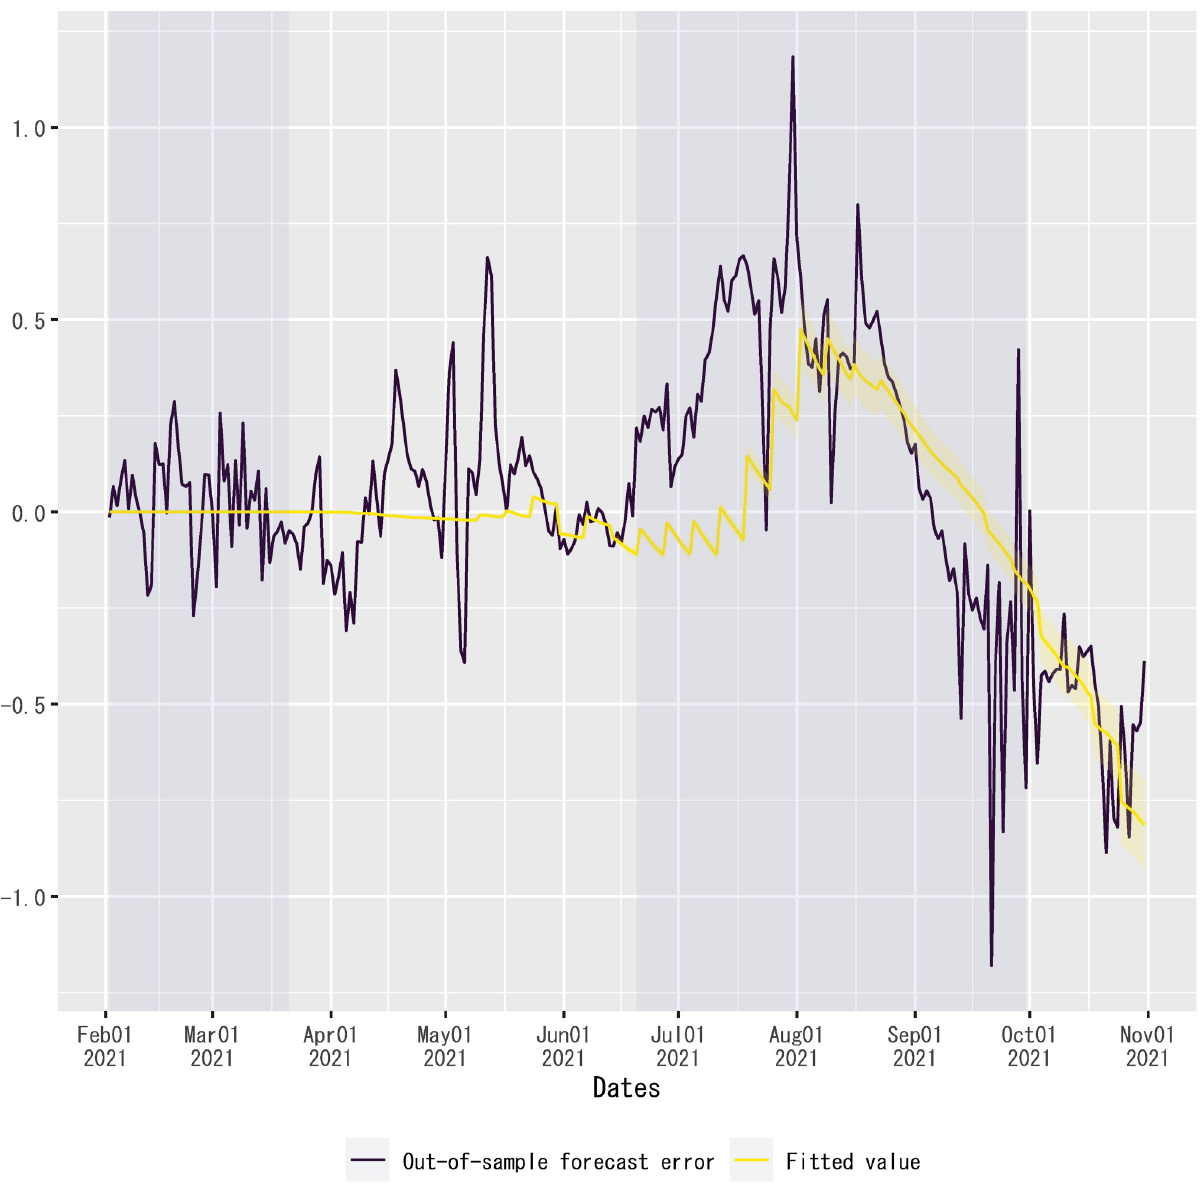
Fig 13. Fitted values of the regression of out-of-sample forecast errors. Notes: “Out-of-sample forecast errors” are out-of-sample forecast errors generated by the regression model with the posterior means of regression coefficients reported in S2 Table “Fitted values” are the fitted values of the regression of the out-of-sample forecast errors reported in Table